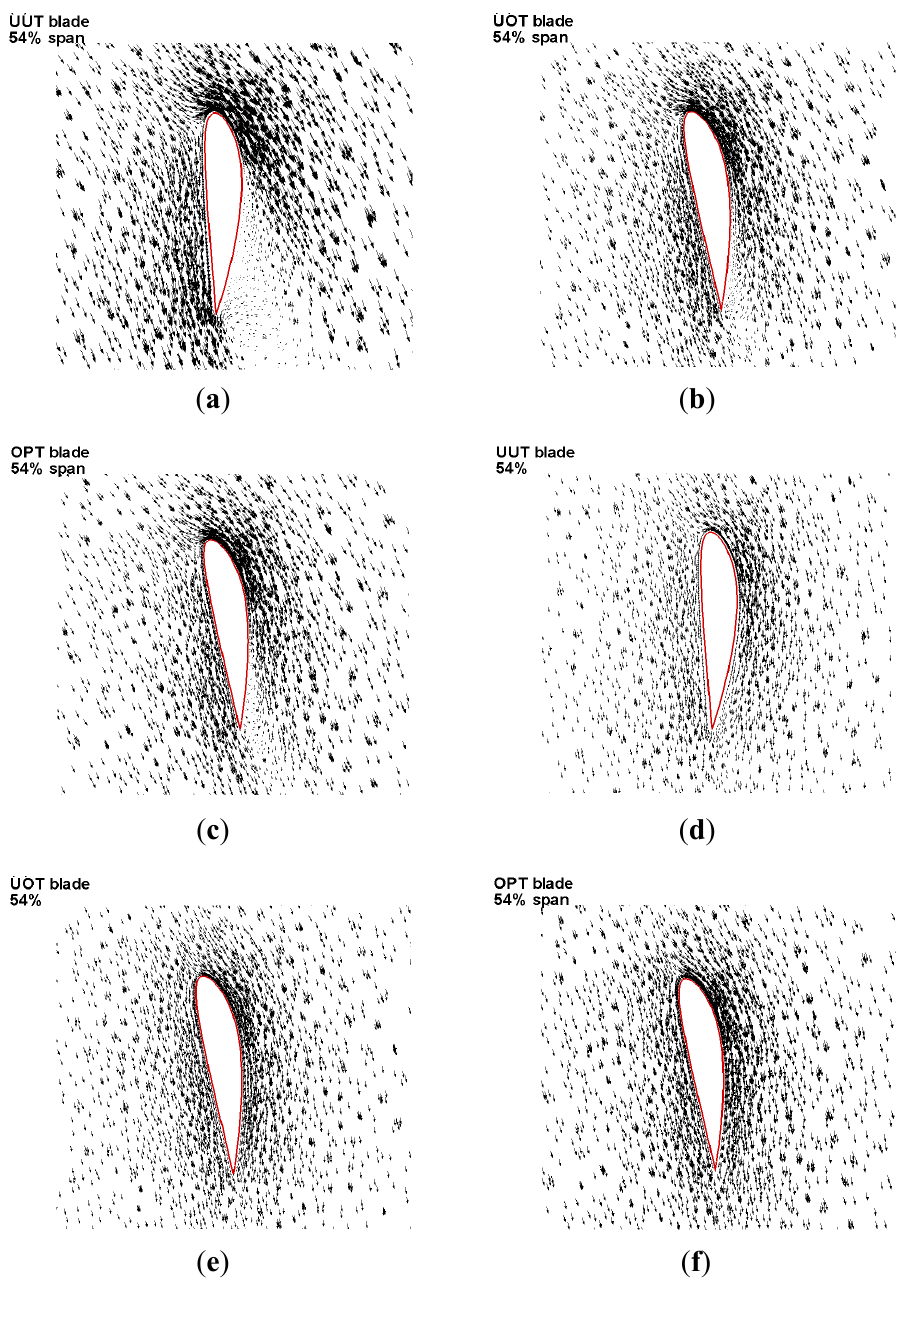
Figure 13. ( a ) The vector plots of flow field for UUT blade in 54% at V = 10 (m/s) and λ = 3; ( b ) The vector plots of flow field for UOT blade in 54% at V = 10 (m/s) and λ = 3; ( c ) The vector plots of flow field for OPT blade in 54% at V = 10 (m/s) and λ = 3; ( d ) The vector plots of flow field for UUT blade in 54% at V = 10 (m/s) and λ = 5; ( e ) The vector plots of the flow field for the UOT blade in 54% at V = 10 (m/s) and λ = 5; ( f ) The vector plots of flow field for OPT blade in 54% at V = 10 (m/s) and λ =